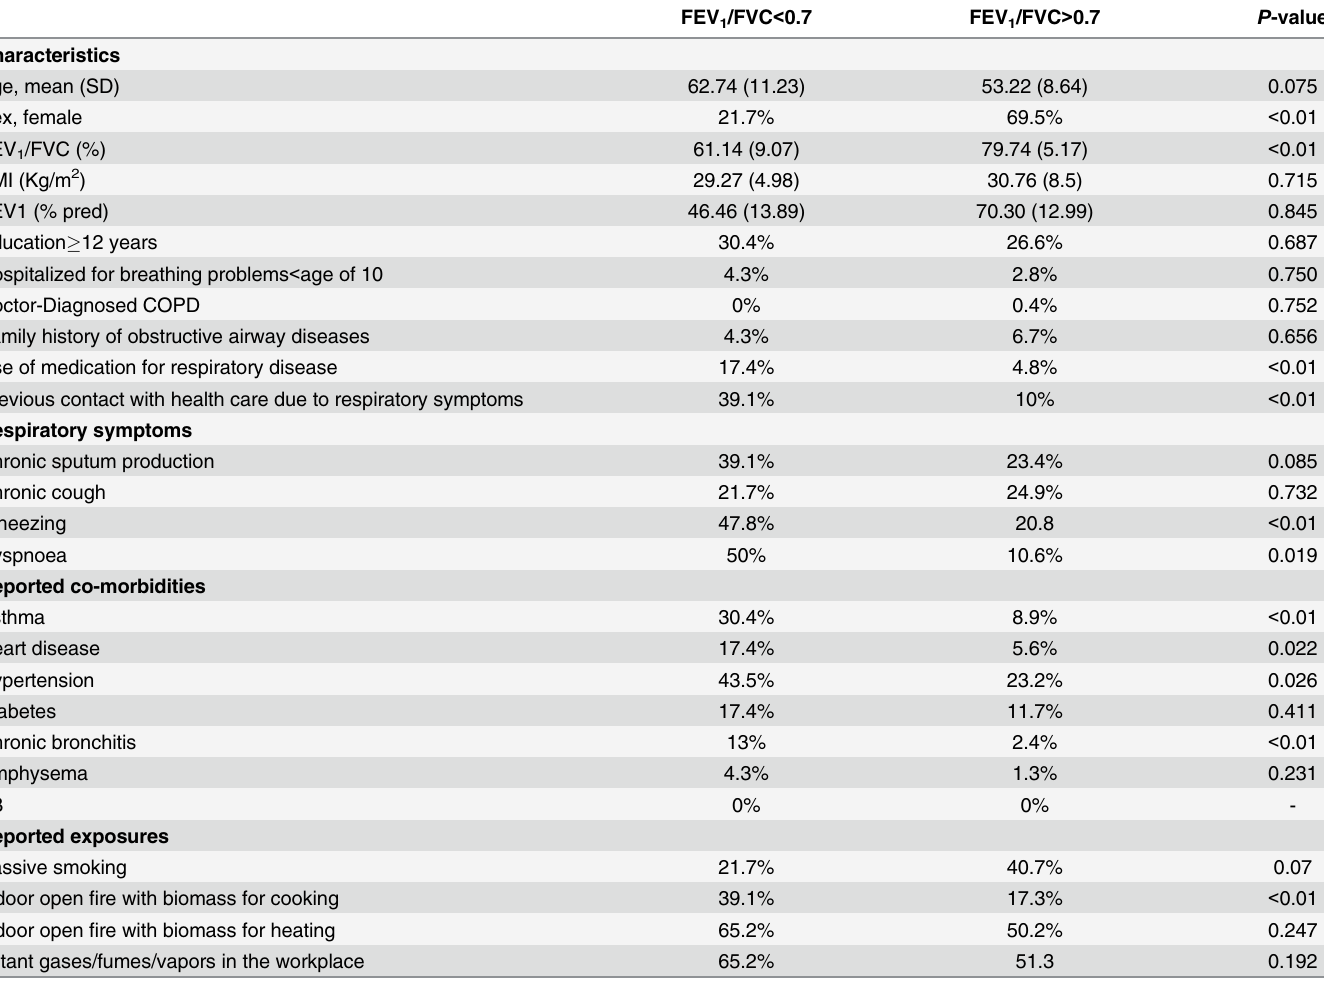
Table 4. Respiratory symptoms, co-morbidity, family history of obstructive airway disease, health care consumption and previous physician diag- nosis of airway disease in nonsmokers with and without non-reversible airway